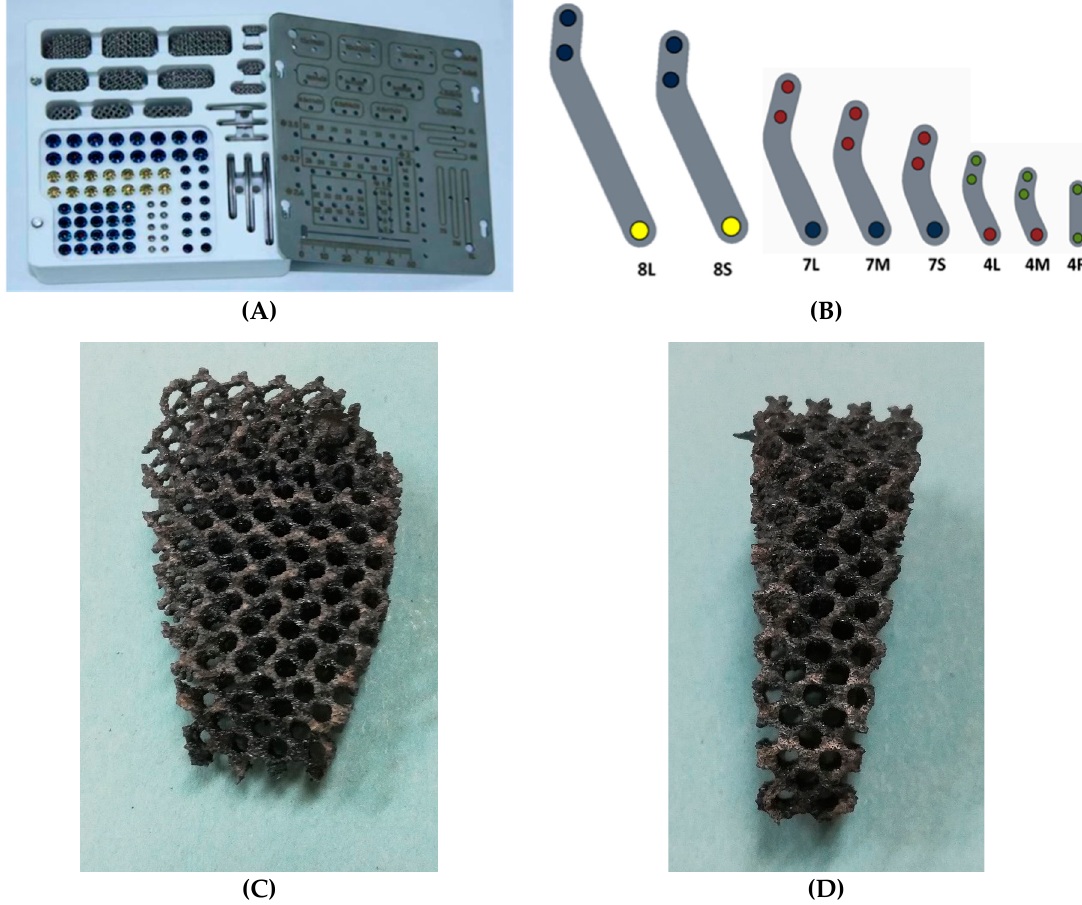
Figure 3. ( A ) The commercial kit with various sizes of titanium porous scaffolds, plates and screws; ( B ) Plates available within the kit; scaffolds of different size available within the kit. ( C ) Frontal view; ( D ) Lateral view. The cage and the implants were produced and developed from “Biosurgex European Union Trademark; category of Medical Instrument Products, Pharmaceutical Products” OHIM Application number 017891671.